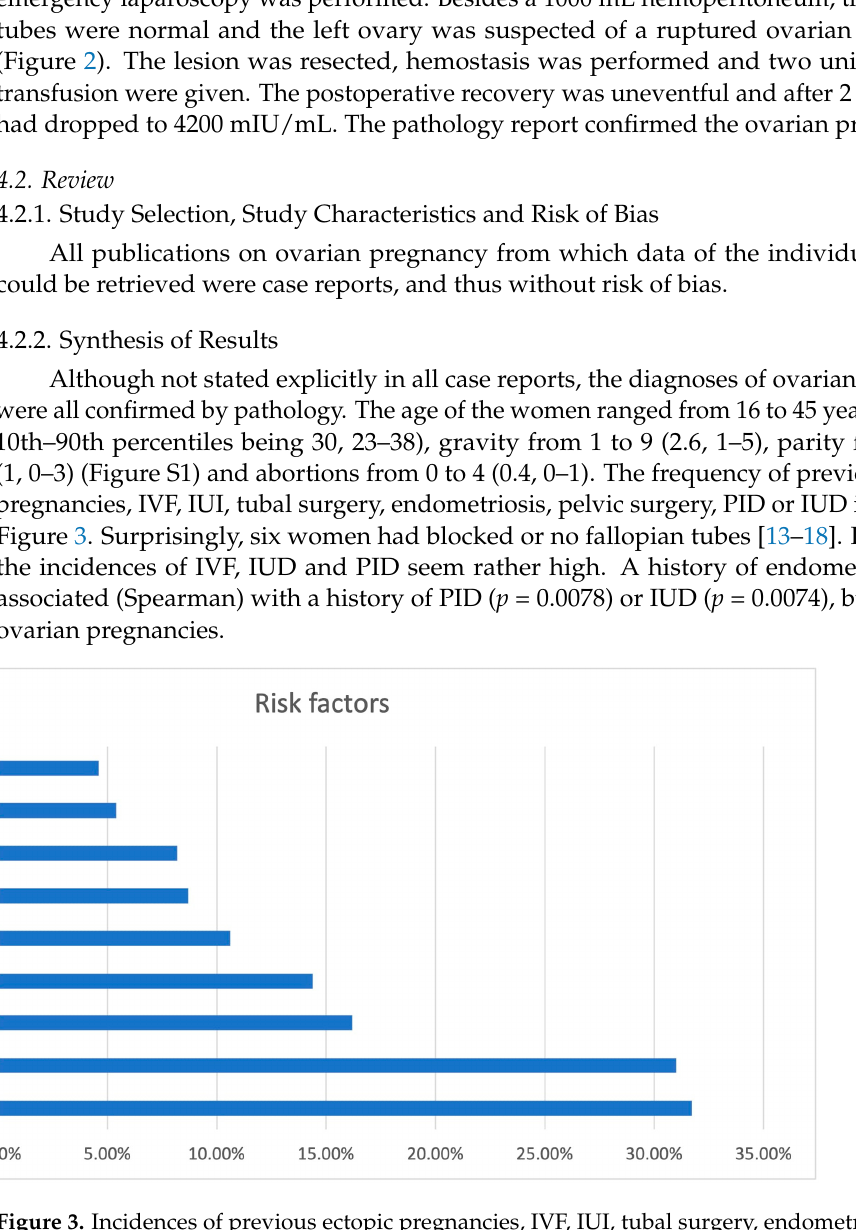
Figure 4. Duration of amenorrhoea in ovarian pregnancies.